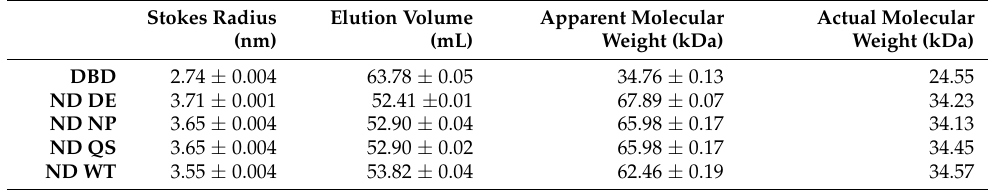
Figure 8. Size exclusion chromatography is used to compare p53 constructs. Elution profiles of p53 constructs where lower elution volume indicates a larger hydrodynamic radius: DBD, ND DE, ND NP, ND QS, ND WT. Table 3. Stokes radii and apparent molecular weights of p53 constructs assessed by